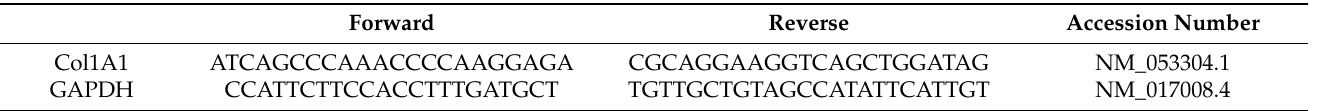
Table 1. The list of primers used for